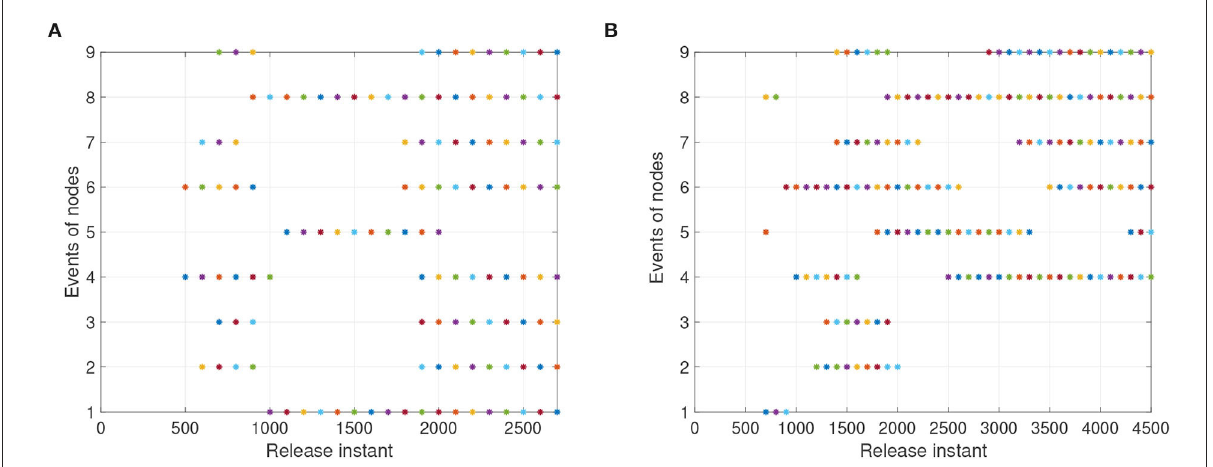
FIGURE7 The events with event-triggered control. (A) Instants for synchronization ε ( t )